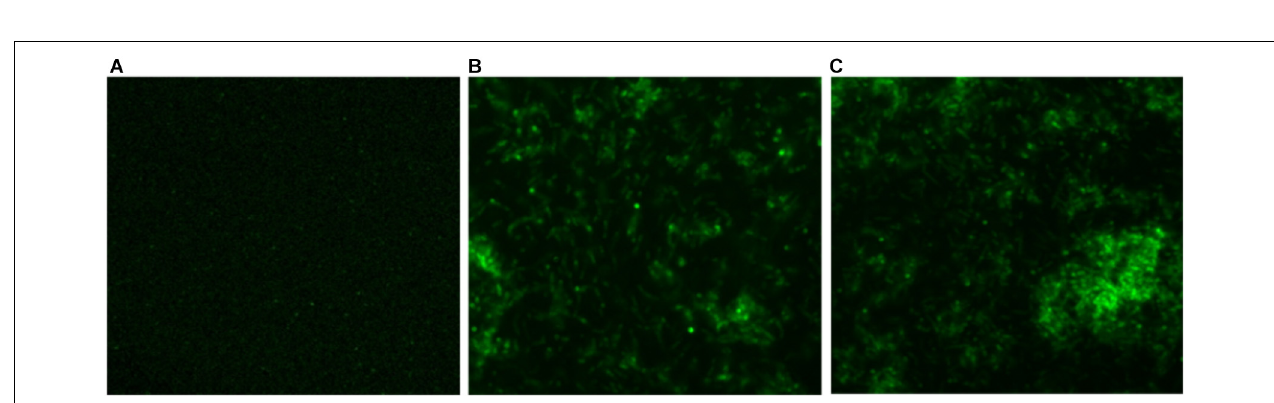
FIGURE 3 | CNPs treatments disintegrate the M. smegmatis cell wall. (A) Scanning electron microscopic images showing disruption in cell wall morphology of single M. smegmatis (control) and after exposure to as-synthesized CNP-L (100 µ g/ml) for 36 h. (B) (i) Control M. smegmatis biofilm (untreated), (ii) CNP treatment inhibits the biofilm formation, and (iii) CNP-L treatment at the same dose showed more biofilm inhibition after 36 h. (C) Biofilms were grown and treated with CNP and CNP-L followed by incubation with XTT for 1 h, absorbance at 495 nm was measured for biofilm inhibition. Increased killing of M. smegmatis was observed at 200 µ g/ml dose of CNP-L. Note : scanning electron microscopy analysis was performed on a SU1510 scanning electron microscope (Hitachi, Tokyo, Japan).